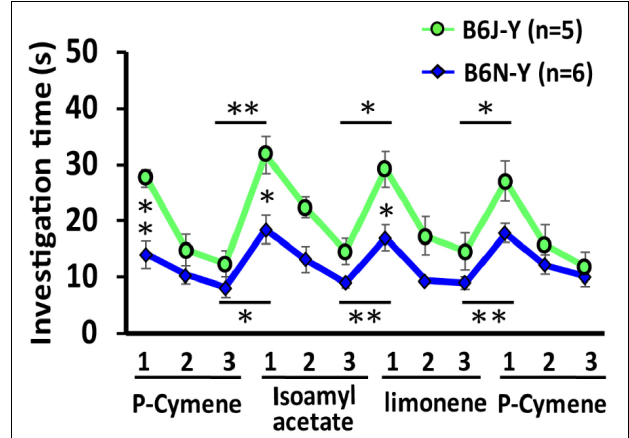
FIGURE 7 | Olfactory habituation or dishabituation test on B6J and B6N mice during young adulthood. A line chart shows how animals of both substrains investigated a cotton swab scented with identical or different odorants in different 3-min trials. ∗ p < 0.05. ∗∗ p <